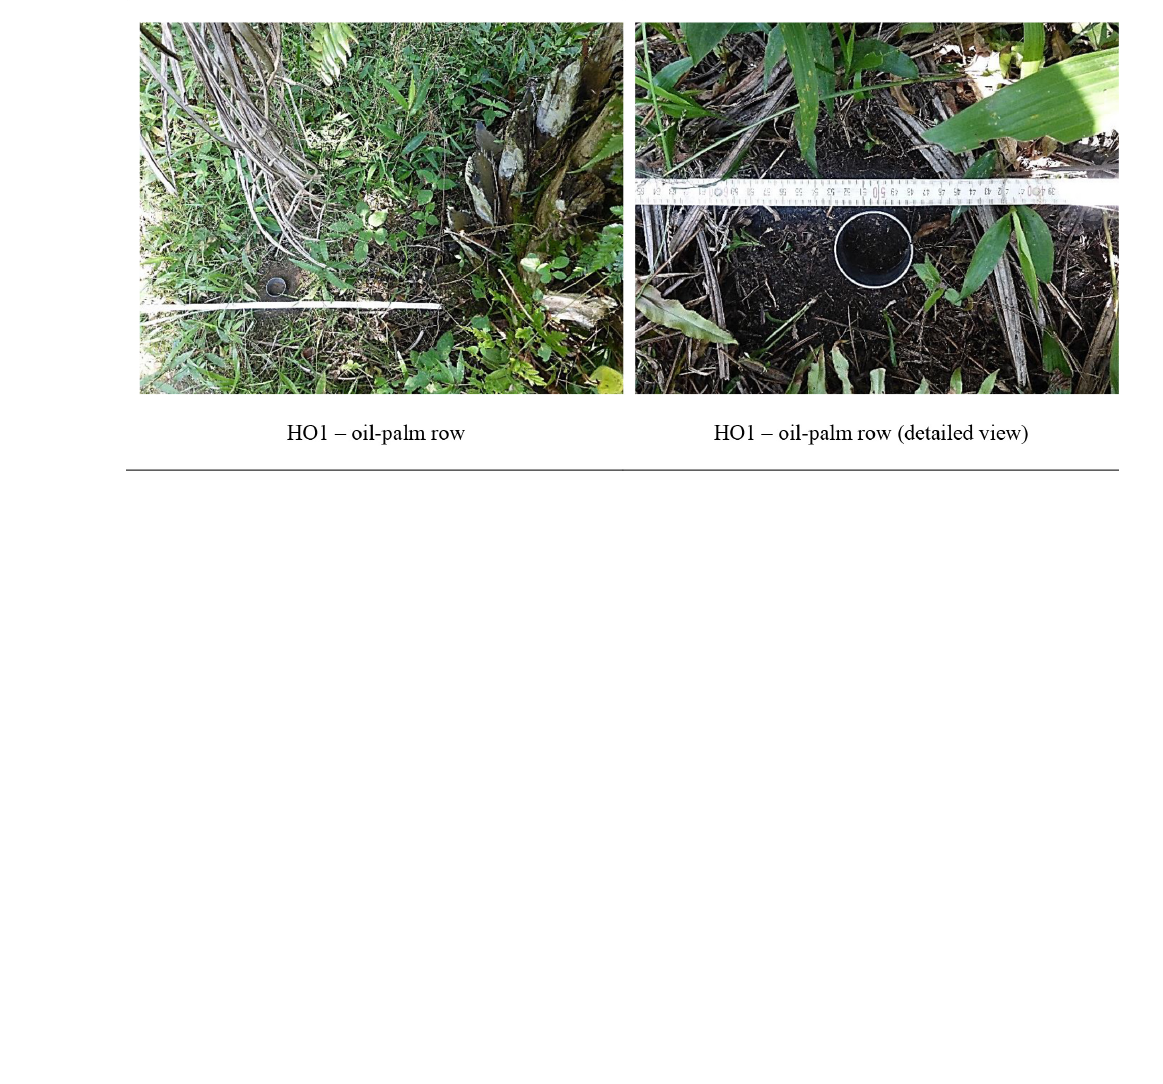
Table A2. Topsoil sampling, fieldwork